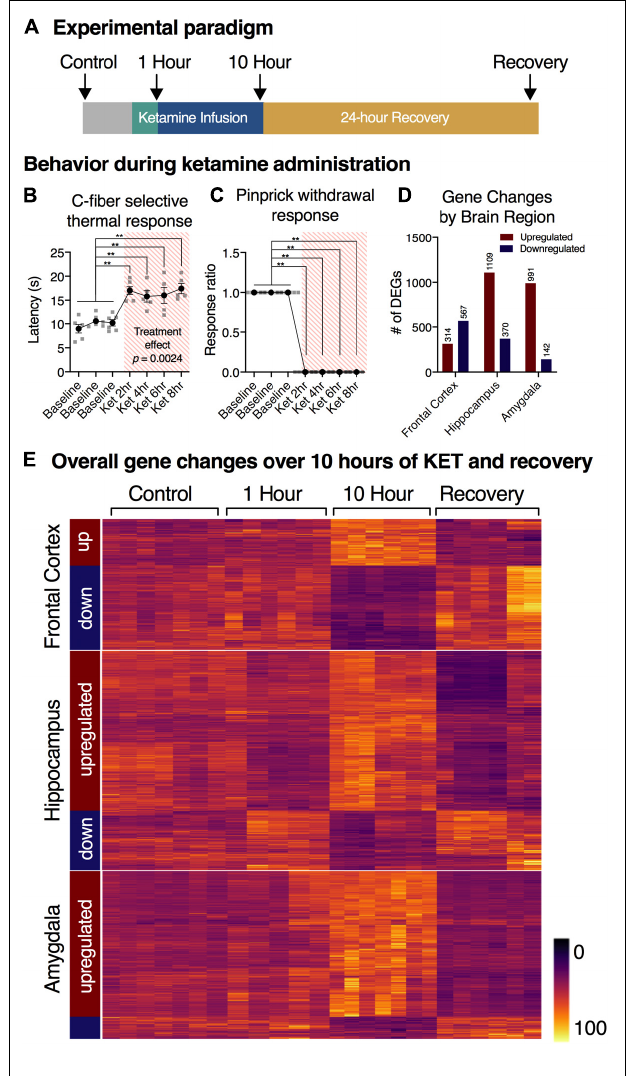
FIGURE 2 | Experimental overview and summary of RNA-Seq findings. (A) Timeline of experimental procedures. RNA-Seq was performed on the frontal lobe, hippocampus, and amygdala from sham operated controls ( n = 7), 1 h infusion ( n = 6), 10 h infusion ( n = 7), and 10 h infusion + 24 h recovery ( n = 6). (B,C) Response to thermal C-fiber activation, and mechanical pinprick are attenuated during the ketamine infusion. These responses indicate blockade of pain sensation in both modalities. Statistics were performed using a mixed-effects model (thermal), or binomial test (pinprick) with Holm-Šidák corrections ( n = 6). Error bars show standard error of the mean. For pinprick response (C) , no variance was observed. (D) Total number of genes regulated as assessed by RNA-Seq. Differentially expressed genes (DEGs) were defined as those with adjusted p -value < 0.01 and had > 40% expression ratio at 10 sFPKM (variable expression ratio threshold, see “Materials and Methods”). Datasets were analyzed using statistical package limma. The total number of genes meeting threshold were as follows: Frontal Cortex: 314 up, 567 down; Hippocampus: 1109 up, 370 down; Amygdala: 991 up, 142 down. Note that in the amygdala and hippocampus there were more upregulated genes, whereas in the frontal cortex roughly equal numbers of significantly up- and downregulated genes were observed. (E) Clustering of gene changes by brain region. Note that the most prominent gene changes occurred at the 10 h time point, and the genes clustered according to direction at 10